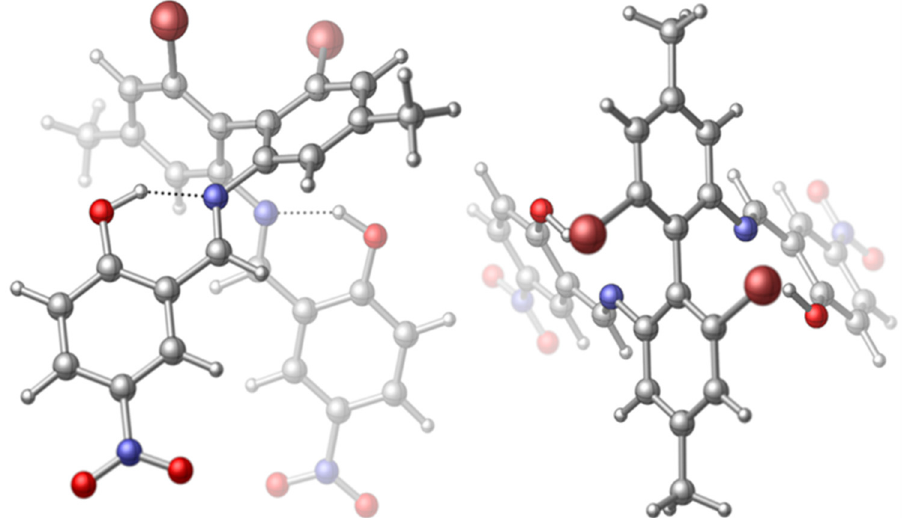
Figure 4. Different views of the optimized ground-state geometry for the ZH4 ligand at the B3LYP/6-31G(d) level of theory. (O: red, N: blue, C: gray, and Br: brick). Dotted line for O–H···N hydrogen bonding. Table 1. Selected calculated and experimental bond lengths (Å) and angles (°) of ZH4